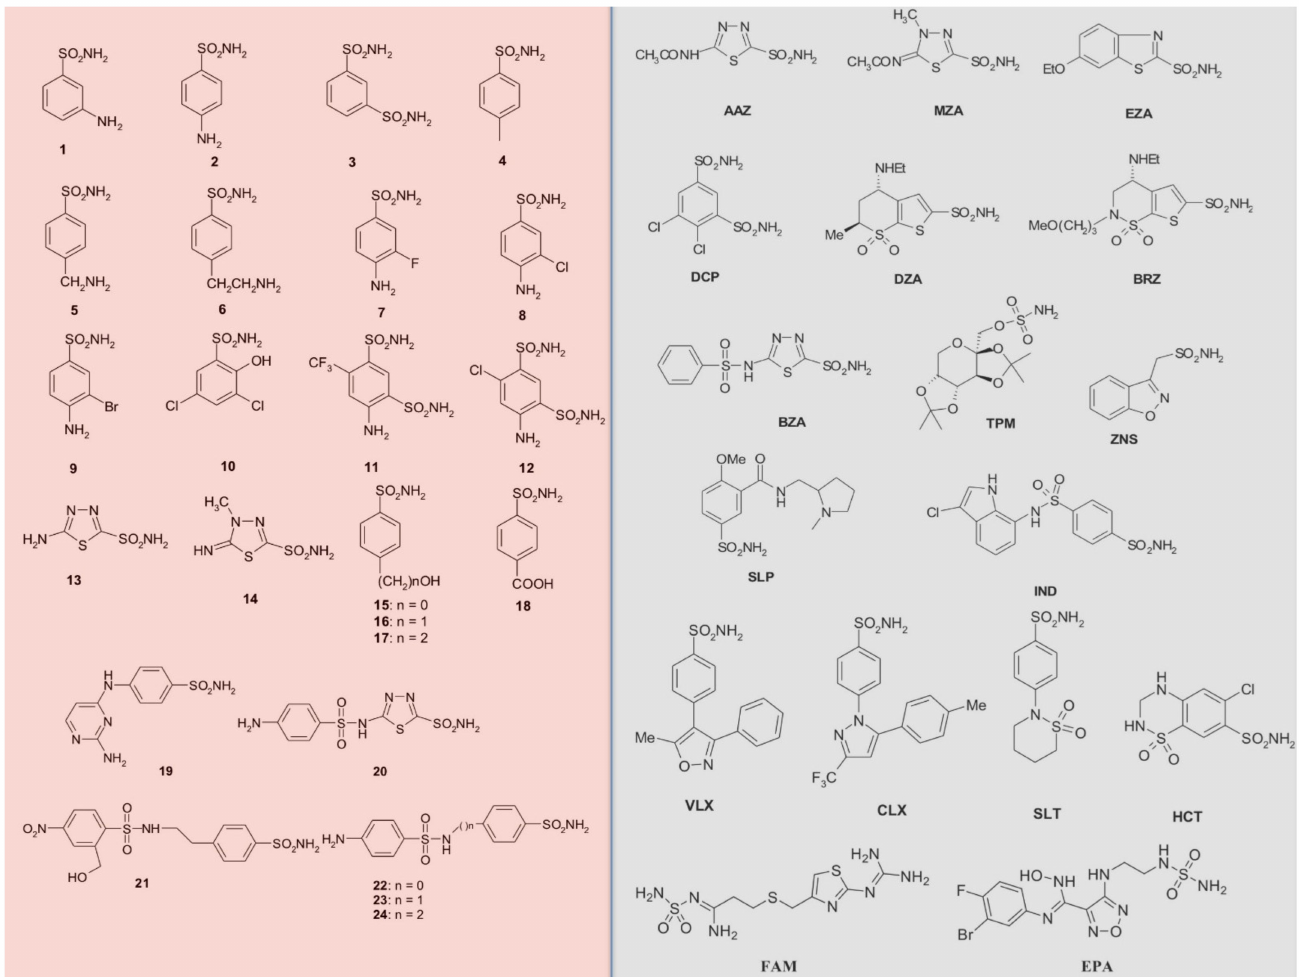
Figure 1. Sulfonamide/sulfamate/sulfamide of types 1 – 24 (pink background) and AAZ-EPA (gray background) in- vestigated as fungal CA inhibitors. Legend: AAZ , acetazolamide; MZA, methazolamide; EZA, ethoxzolamide; DCP , dichlorophenamide; DZA, dorzolamide; BRZ , brinznolamide; BZA, benzolamide; TPM, topiramate; ZNS , zonisamide; SLP , sulpiride; IND, indisulam; VLX, valdecoxib; CLX, celecoxib; SLT, sulthiame; HCT, hydrochlorothiazide; FAM, famotidine; EPA ,